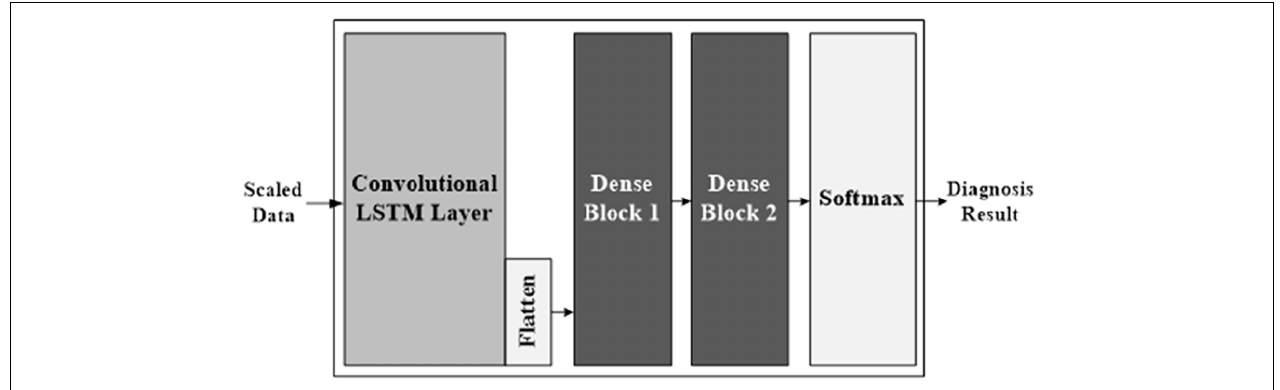
FIGURE 1 | Structure of the improved ConvLSTM.